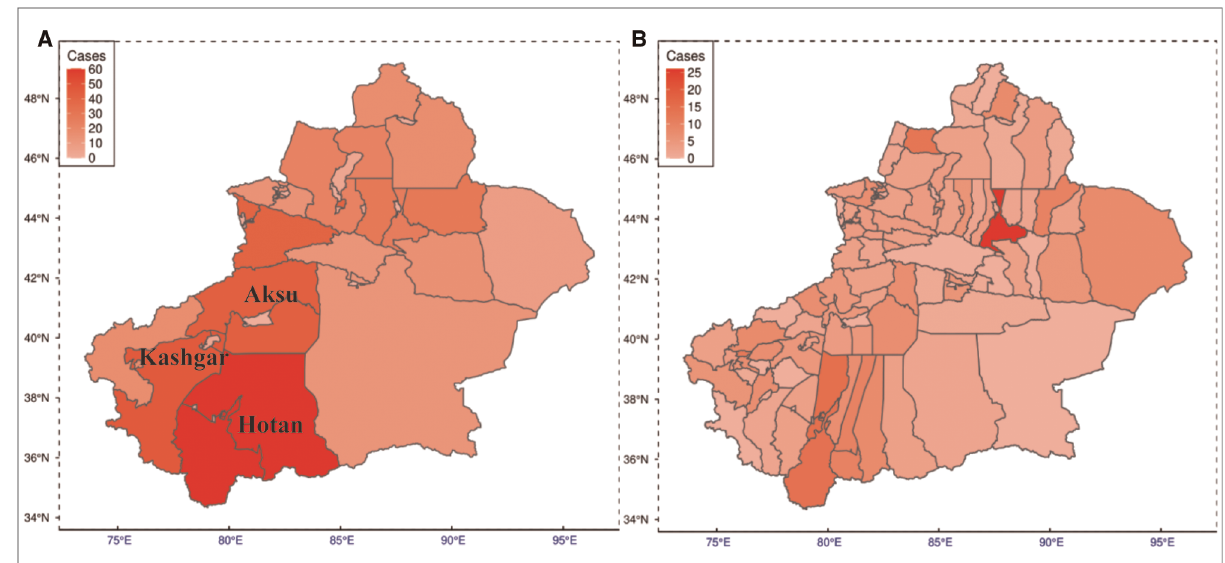
FIGURE 1 Prevalence of TS and BS among northwestern Chinese residents. ( A ) Prevalence map of the regional level. ( B ) Prevalence map of the county level. TS, tuberculous spondylitis; BS, brucellar